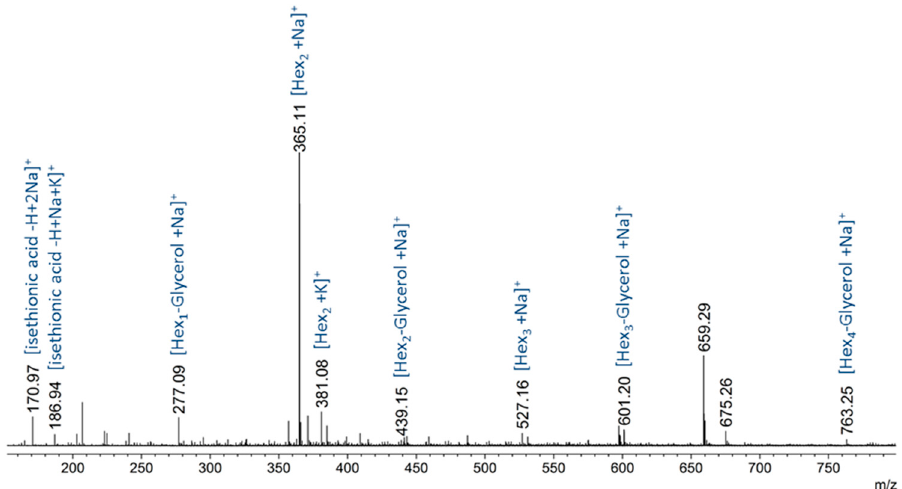
Figure 2. Electrospray ion (ESI)-MS (+) spectrum of the fraction containing the (hexose) 1–4 -glycerol species.